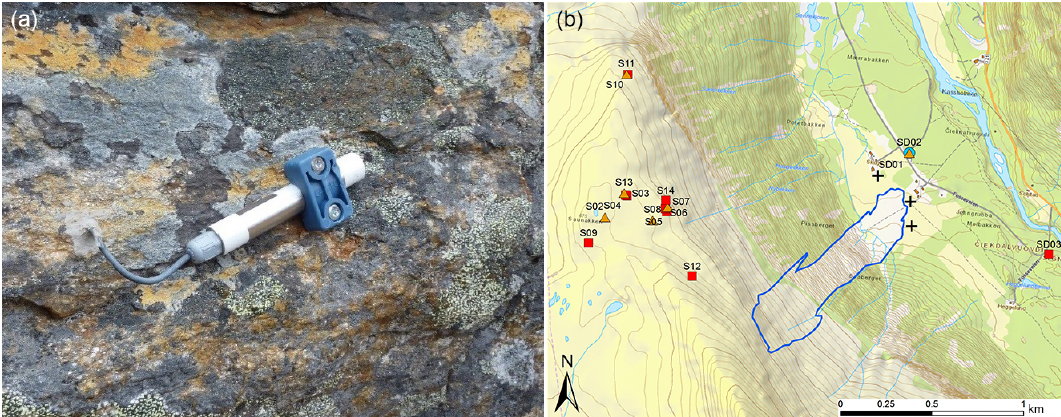
Figure 3. (a) Typical logger installation setup for the M-Log5W loggers. (b) Map showing temperature measurement locations in vertical rock faces (red squares), within soil material (yellow triangles), and within a stone cairn (one blue circle in the valley bottom). The three black crosses mark the laser scanning locations. Rock avalanche outline in blue. Map source: Copyright of Norwegian Mapping Authority/Statens